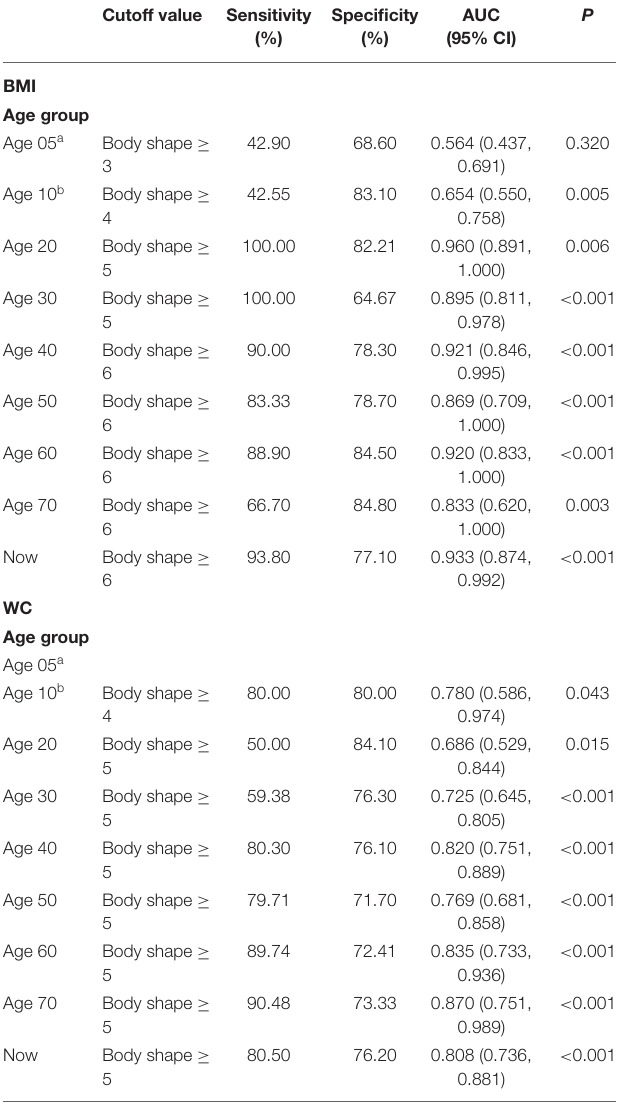
TABLE 4 | The best cut-off value to define obesity based on recalled body shape, and the sensitivity and specificity of the definition. Cutoff value Sensitivity